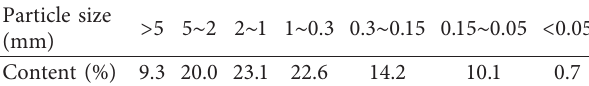
Table 3: Test results of mineral composition of coal zircon.